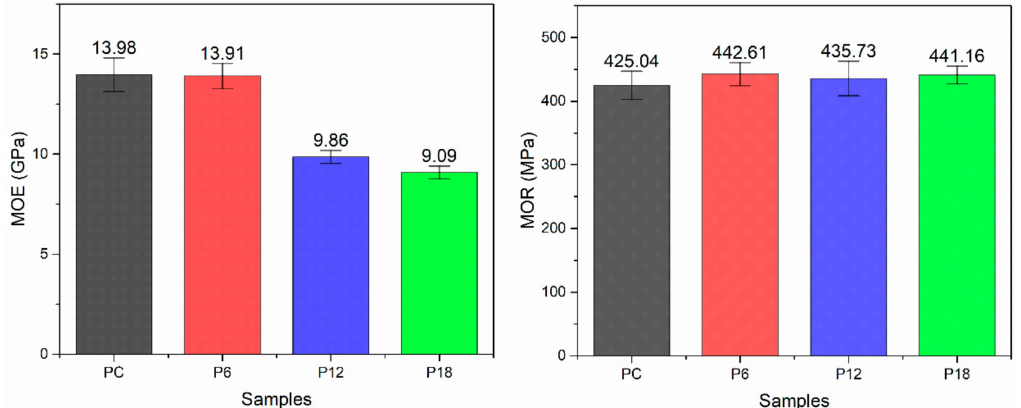
Figure 4. E ff ect of the esterification treatment on the modulus of elasticity (MOE) and modulus of rupture (MOR) of